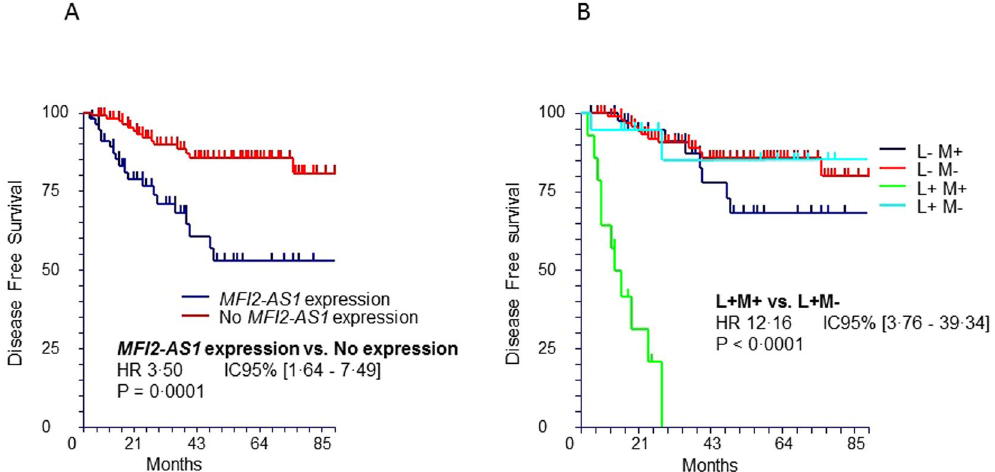
Figure 3. Kaplan-Meier estimates for disease-free survival (DFS) in the validation set. ( A ) DFS according to MFI2-AS1 expression in the entire cohort. ( B ) DFS according to MFI2-AS1 expression and Leibovich subgroups. L + M + (N = 14): Leibovich ≥ 5 + MFI2-AS1 expression. L + M − (N = 18): Leibovich ≥ 5 + No MFI2-AS1 expression. L − M + (N = 42): Leibovich < 5 + MFI2-AS1 expression. L − M − (N = 93): Leibovich < 5 + No MFI2-AS1 expression.